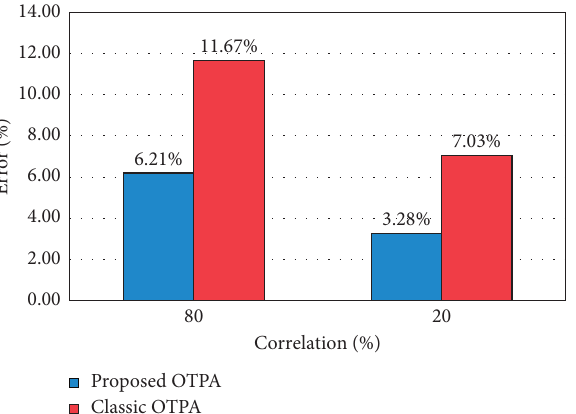
Figure 22: Error of the traditional and proposed OTPA according to correlation.